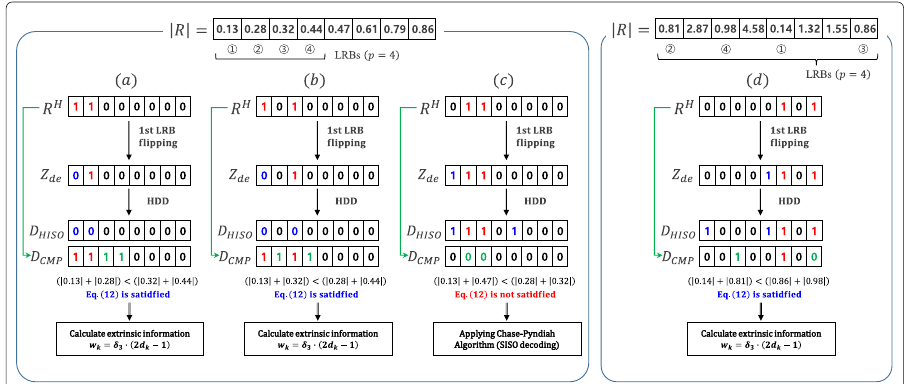
Fig. 4 Examples performing the proposed HISO decoding algorithm when containing two errors in the input vector. Example ( a ) and ( b ) represent the cases of successful error correction via the proposed HISO decoding. By contrast, example ( c ) illustrates the case of wrong error correction. Example ( d ) shows the valid codeword is generated, but it is not the correct